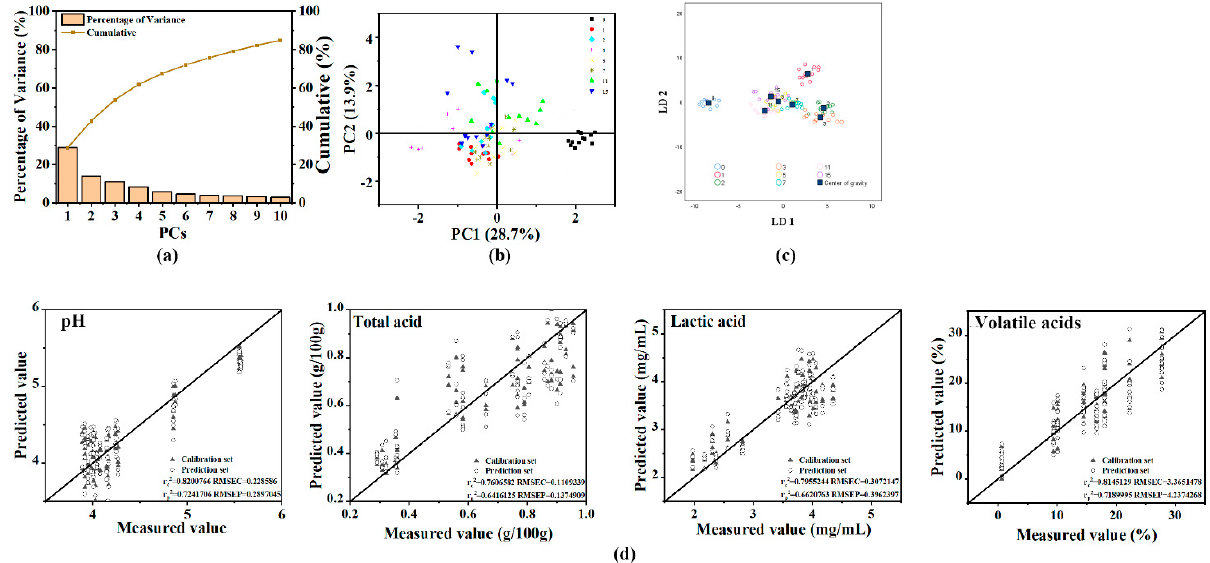
Figure 6. Data analysis of Apo pickle by CAS detection. ( a ) Rate of contribution the first 10 principal components (PCs) of the total variance; ( b ) data grouped by days were analyzed by principal component analysis (PCA); ( c ) data grouped by days were analyzed by linear discriminant analysis (LDA); ( d ) the partial least squares regression (PLSR) prediction result plot of pH, total acids, lactic acid and volatile acids.